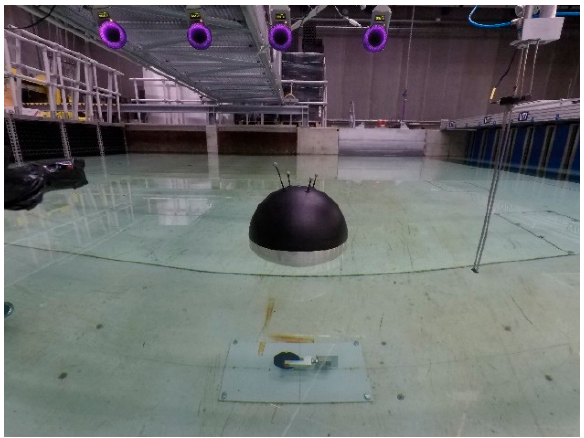
Figure 10. Test setup in the wave basin: center—half-submerged sphere model; background— motion capture cameras (strobes in purple); right—wave gauge (number 3).